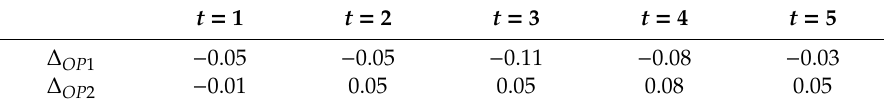
Table 15. Deviational variables for change in future purchasing price of diesel oil.